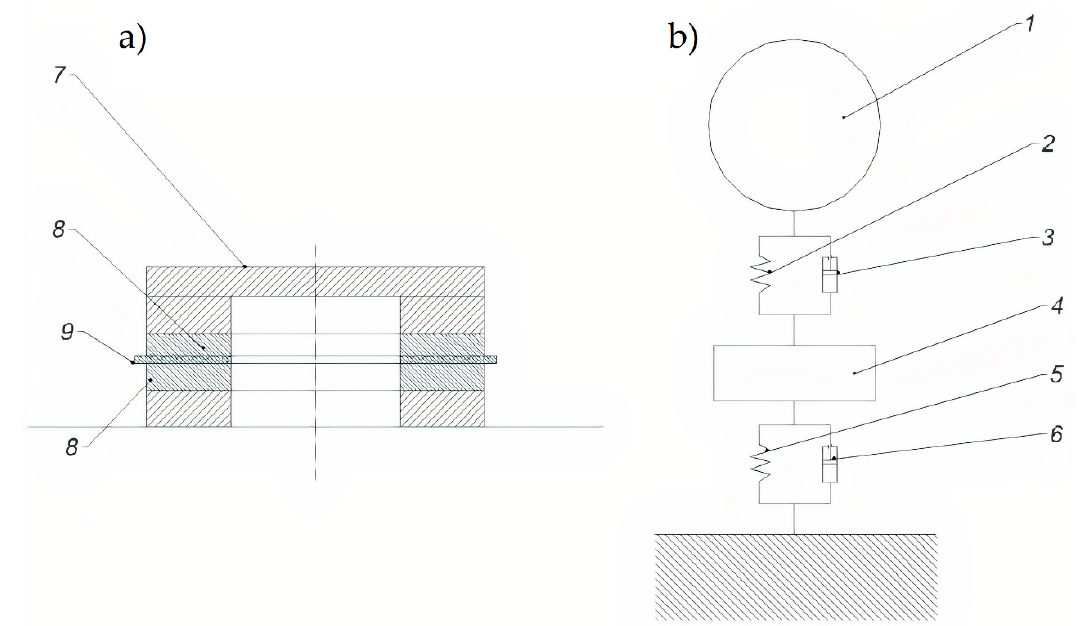
Figure 3. Diagram of a piezoelectric force sensor ( a ) and physical model of the grain sensor system at the moment of impact ( b ): (1) grain mass m 2 , (2) grain contact stiffness k 2 , (3) grain damping parameter c 2 , ( 4) parasitic force sensor mass m 1 , (5) stiffness of the measuring element of the force transducer k 1 , (6) damping of the measuring element of the force transducer c 1 , (7) sensor dial, (8) piezoelectric crystals, and (9) electrode.